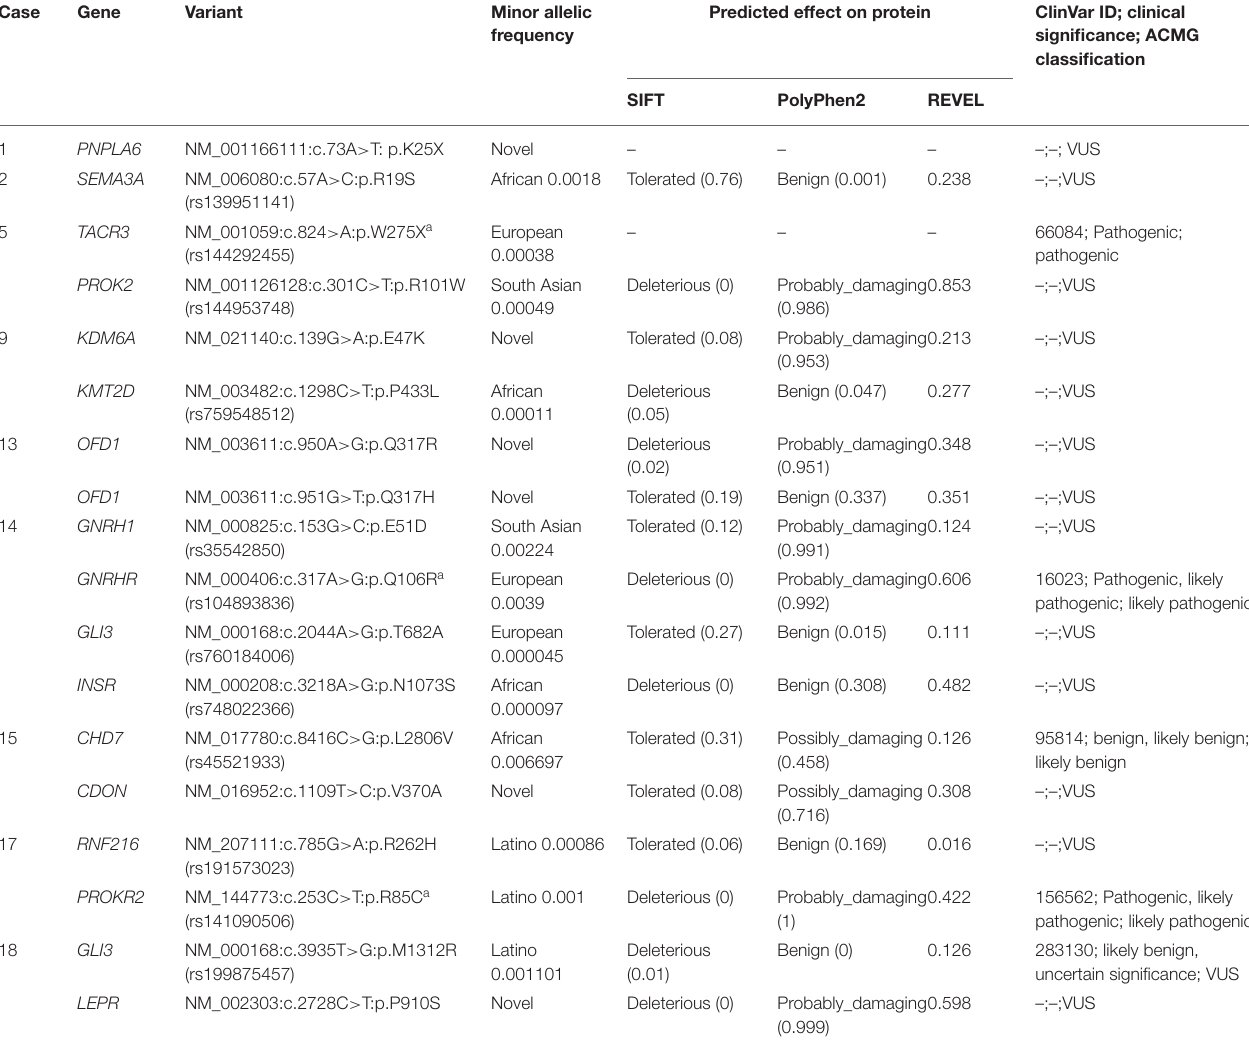
TABLE 2 | Variants in genes associated with both non-syndromic and syndromic HH identified in 9 girls with ovarian